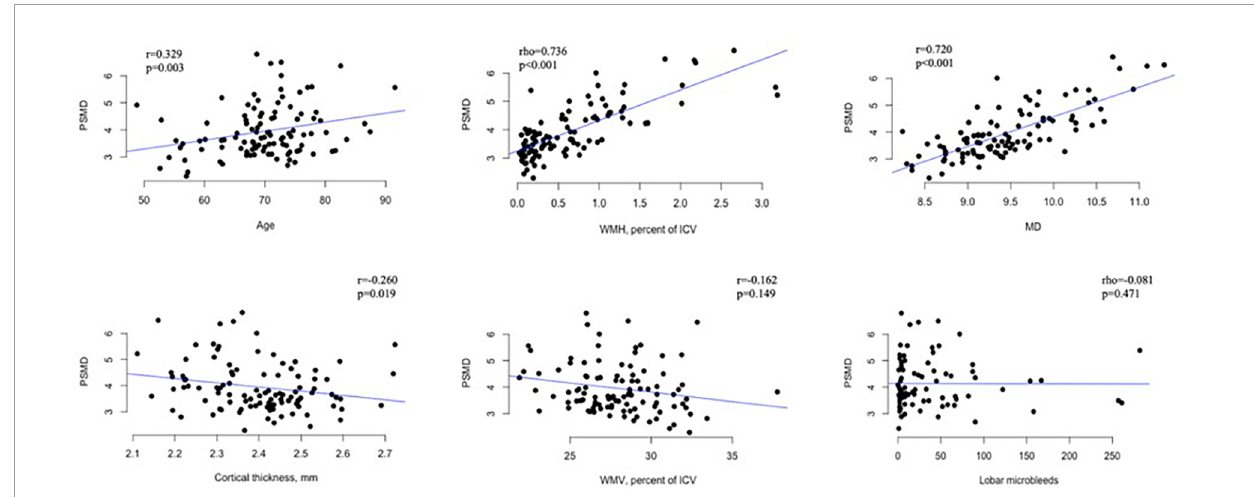
FIGURE3 Scatter plots showing the relationship between PSMD ( × 10 - 4 mm 2 /s) and continuous variables in patients with CAA. PSMD, peak skeletonized mean diffusivity; MD, mean diffusivity; WMH, white matter hyperintensity; WMV, white matter volume; ICV, intracranial